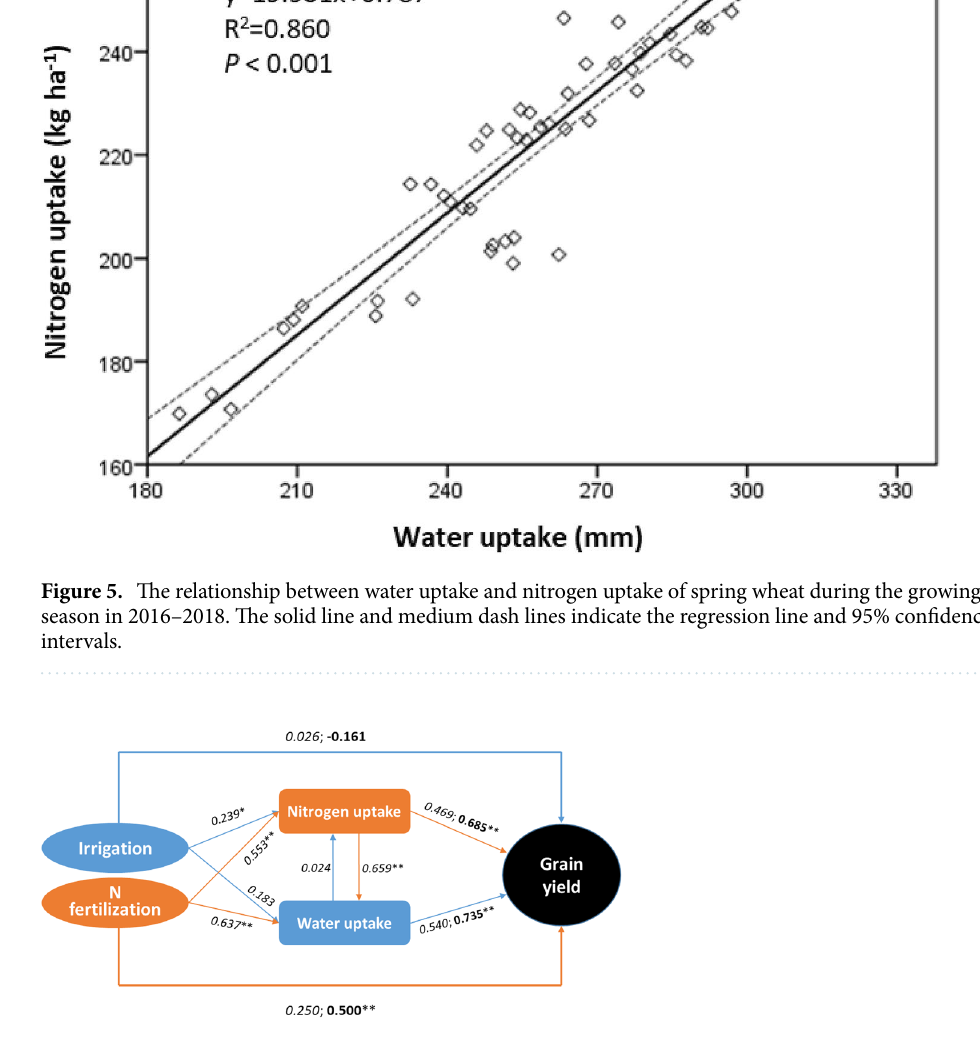
Figure 6. Path analysis of irrigation and N fertilization on grain yield of spring wheat via influence on nitrogen uptake and water uptake across 2016–2018. Fine lines represent indirect pathways and thick lines represent direct pathways. Italicized values are the path coefficient and bold values are the correlation coefficient. * P ≤ 0.05, ** P ≤